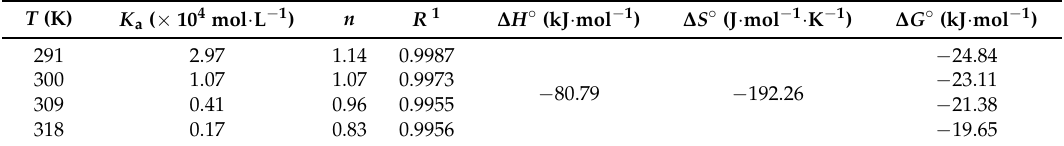
Table 2. Binding constants and thermodynamic parameters from 2-MT/CAT interaction (pH